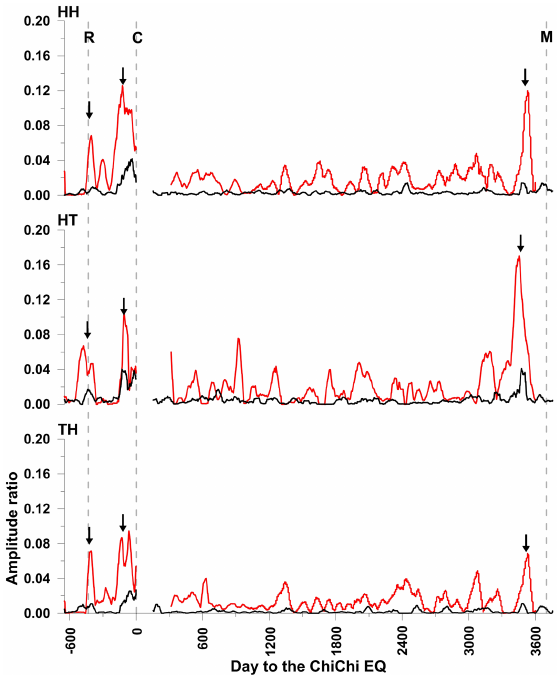
Figure 4. The amplitude ratios of groundwater levels at HH, HT and TH stations from 1 August 1997 to 31 Dececember